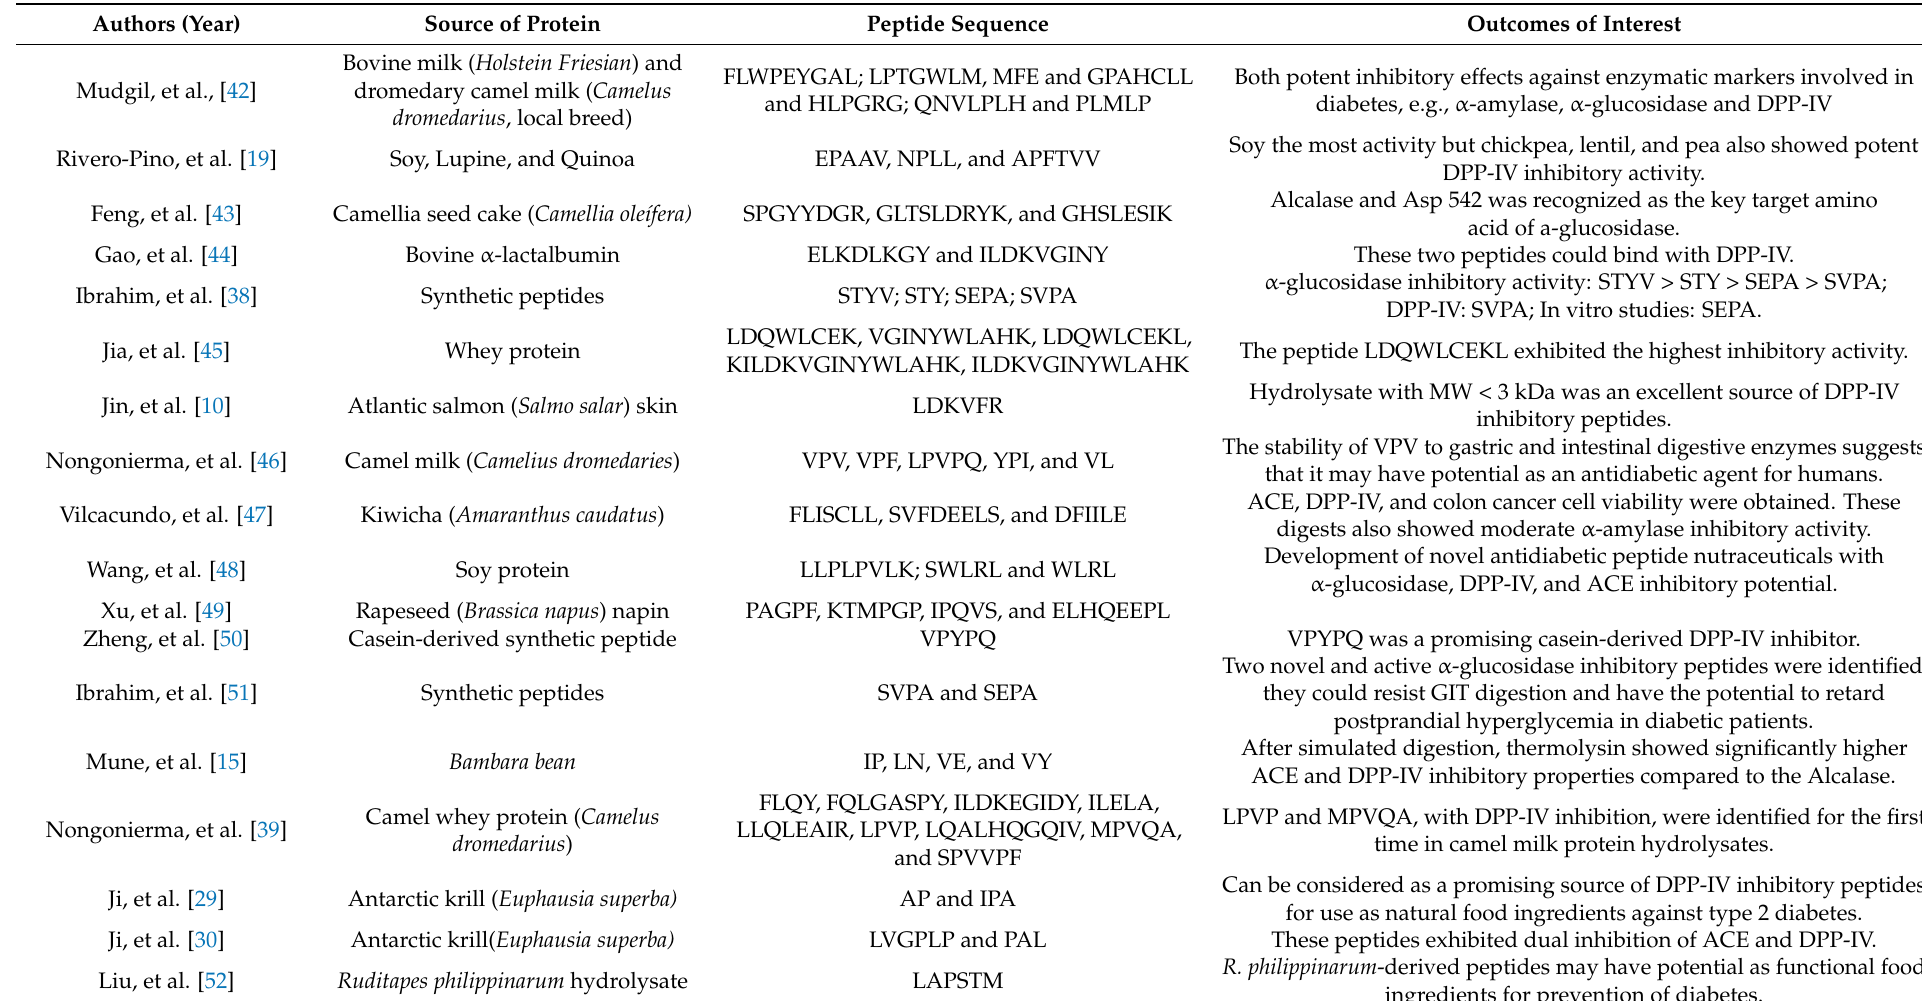
Table 1. Selected studies with peptide sequence and their respective outcomes of